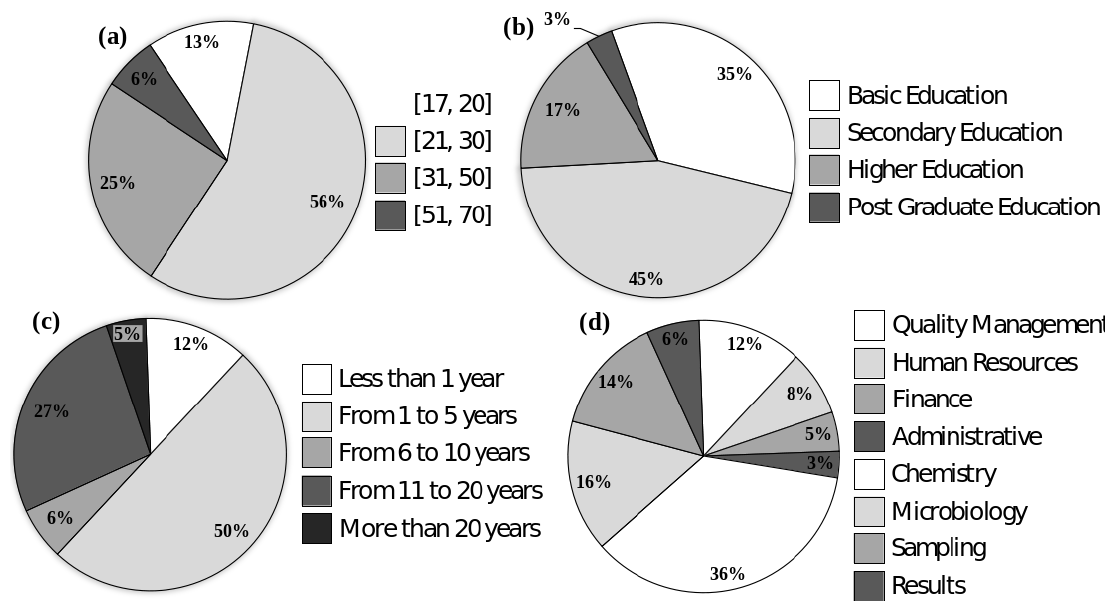
Figure 1: Sample characterization in terms of age groups (a), academic qualifications (b) length of service (c), and (d) departmental areas